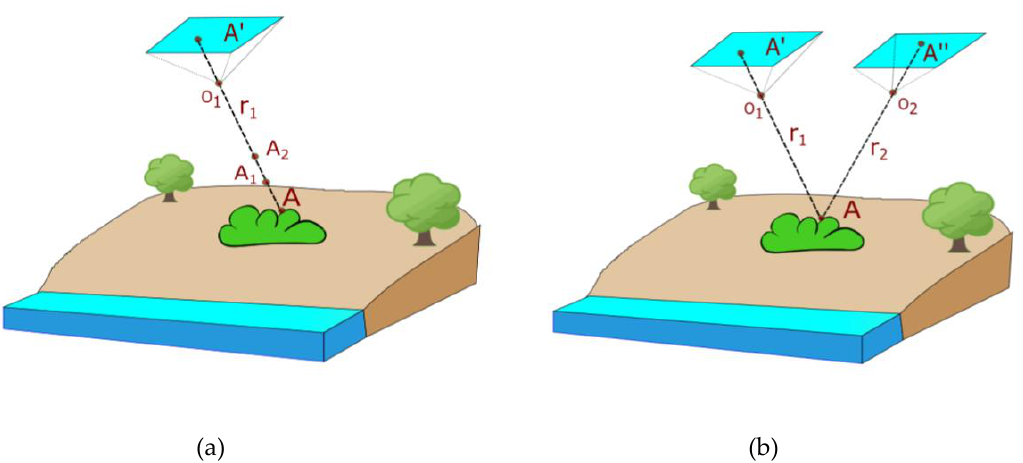
Figure 4. Photogrammetry technique allowing the 3D reconstruction of the objects. By precisely knowing the position of the homologous points A ’ and A ” on the two photographs, and the spatial position of the two sectors and the two perspective centers O1 and O2, the point A remains geometrically defined, since it is the intersection point of the two projecting rays r1 and r2 connecting the two homologous points with the perspective centers ( b ). This does not happen with a single photo shoot ( a ).